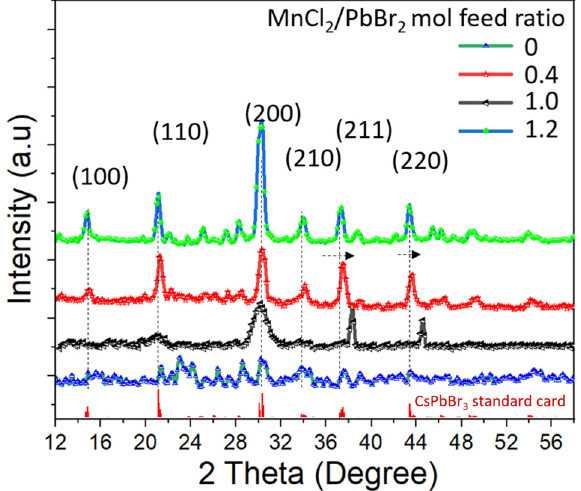
Figure 2: The XRD pattern of CsPb 1 – x Mn x Br 3 – 2 x Cl 2 x ( x = 0 – 0.5 ) NCs with di ff erent MnCl 2 to PbBr 2 mol feed